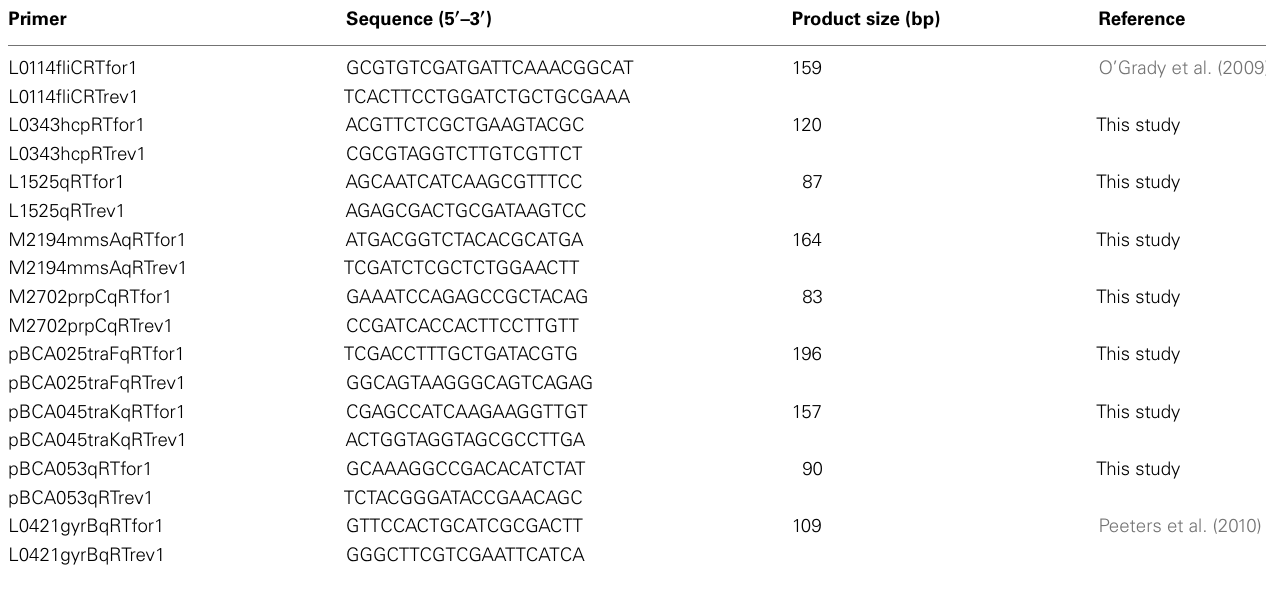
Table 1 | Oligonucleotide primers used in this study for qRT-PCR.